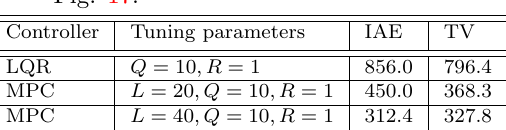
Table 4: Comparing MFPC vs MFLQ using perfor- mance measures: Integrated Absolute Error (IAE) and Total Value (TV). Associated with Fig. 17. Controller Tuning